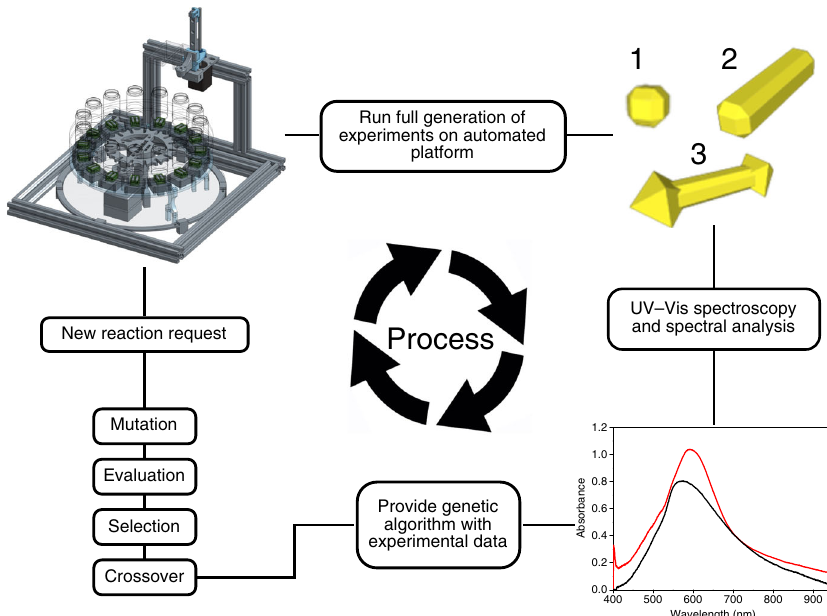
Fig. 2 Scheme of the platform work fl ow for the hierarchical evolution of AuNPs. (proceeding clockwise from top left position) The platform itself (see SI for build details). Each new series of reaction generations aims for a speci fi ed spectral target, beginning with a random exploration of the chemical space. Volumes of stock reagents are initially selected at random, dispensed by the platform and analysed by in-line UV-Vis spectroscopy. The resultant spectra are assigned a fi tness value and evaluated via our genetic algorithm. The algorithm mutates the experimental parameters and crosses them over attributes of the highest fi tness samples to generate new experimental parameters for the next generation. The cycle repeats until the target was reacted, each 15-reaction generation of a given series proceeding towards the prede fi ned spectra.